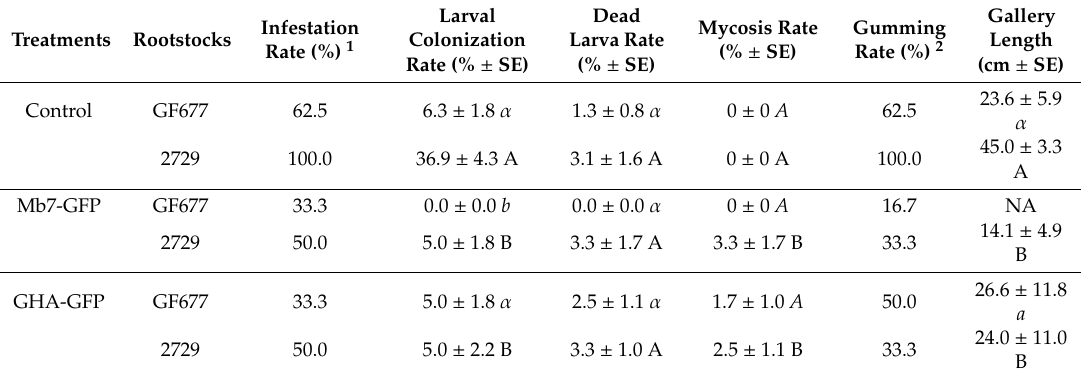
Table 5. Trial 2019: e ff ects of C. tenebrionis larvae on potted rootstocks of GF677 and 2729 treated